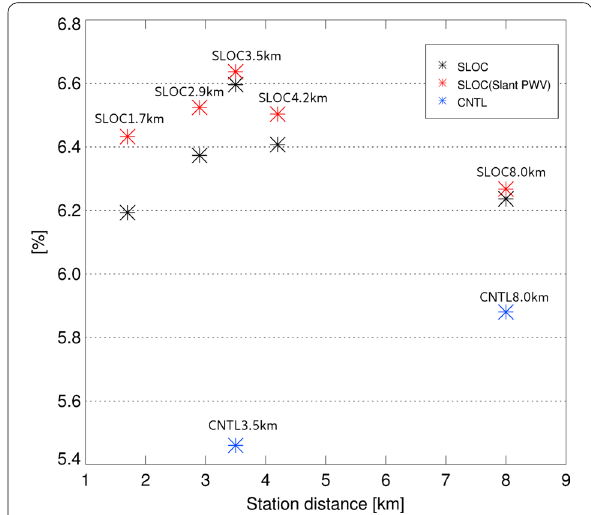
Fig. 12 Improvement rates of RMSE of hourly rainfall amount simulated by the inner domain model as a function of the inter- station distances of the assimilated PWV data. To calculate the mean improvements of RMSE, we used the ensemble mean data of each inner model cycle during 0200–0600 LT on August 14, 2012, i.e., four samples. Red- and black-colored symbols indicate that assimilated PWV data around Uji shown in Fig. 1b were PWV SPD-H and PWV CON, respectively, using the SLOC localization setting. The blue-colored